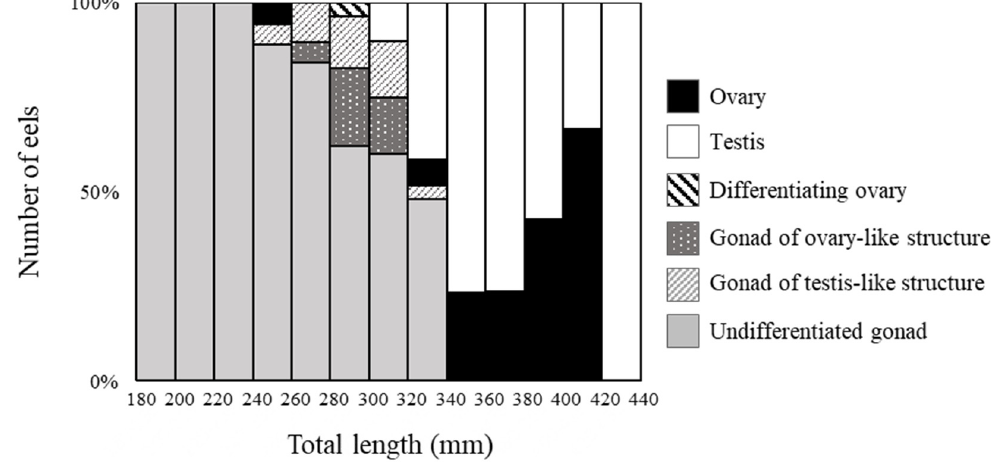
Figure 4. Percentage of morphological sex-differentiated eels with respect to body growth. Gonadal development was classified into six stages, and eels of each size were counted.